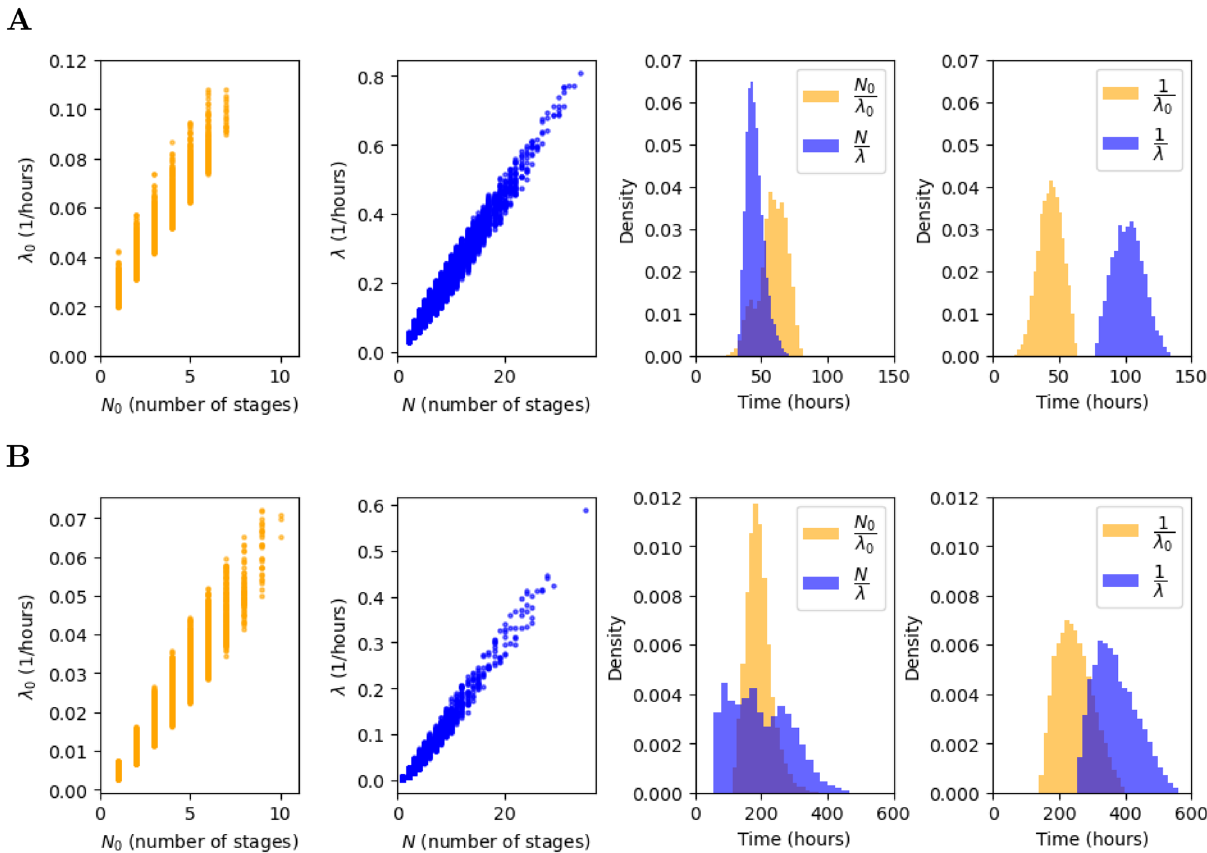
Figure 10. Joint posterior distributions (left two plots) of the number of stages N 0 , N and the birth rates (cid:31) 0 , (cid:31) . Marginal posterior distributions (right two plots) for the mean time to first and subsequent divisions estimated from the multi-stage model (third column) and the exponential model (fourth column). Panel A for OT-I T cells and B for F5 T cells.